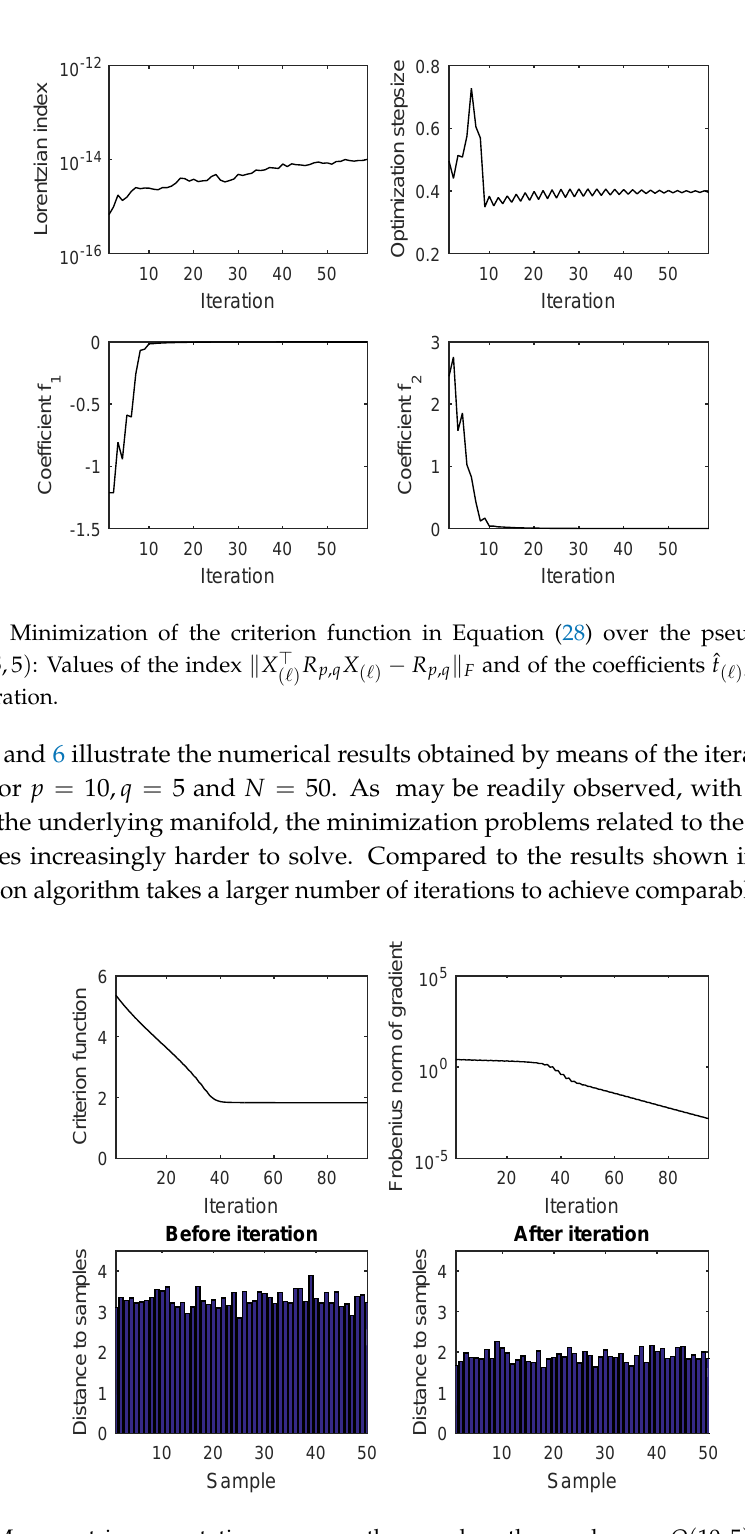
Figure 5. Mean-matrix computation over over the pseudo-orthogonal group O ( 10,5 ) : Values of the criterion function in Equation (28) during iteration, Frobenius norm of its pseudo-Riemannian gradient, distances D F ( X , X k ) before iteration ( X = X ( 0 ) ) and after iteration ( X = µ )